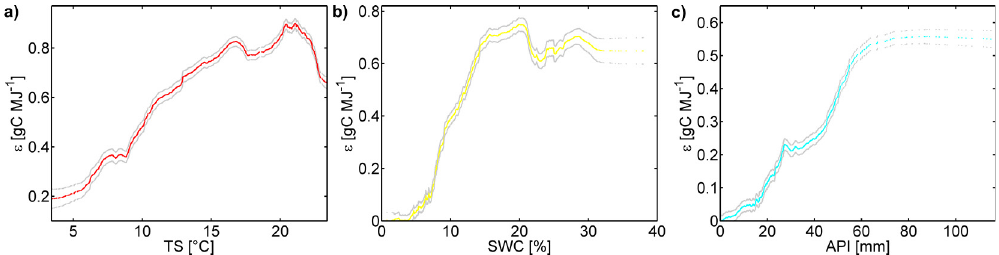
Fig. 4. (cid:15) depending on the major driver of F G as obtained by a SDP-model with one state variable (Eq. 4 with N =1). State variables explaining (cid:15) were T S at Duke, SWC at Vaira Ranch. API and Audubon. The grey bounds encompassing the estimated relationship represent the standard errors of the SDP